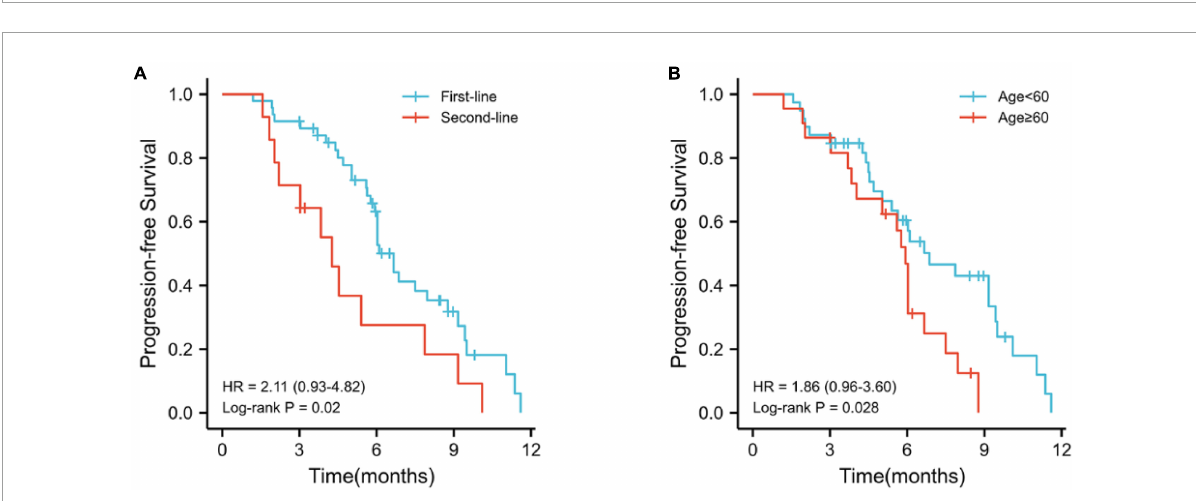
FIGURE5 Kaplan–Meier survival analyses. (A) Kaplan–Meier curve for comparison of PFS between first-line treatment and second-line treatment; (B) Kaplan–Meier curve for comparison of PFS between old age ( ≥ 60) and young age ( < 60).